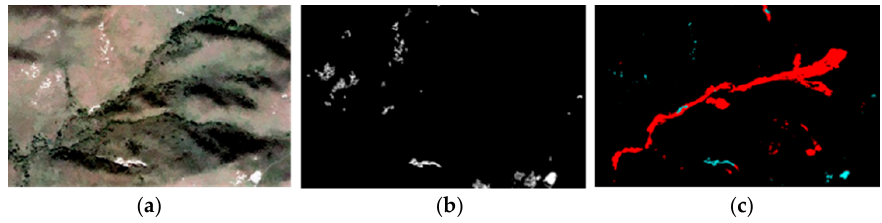
Figure 11. Reconstruction and segmentation results of the pre-event image: ( a ) reconstruction result using MMR (the structuring element is a disk of size 5 × 5); ( b ) candidate false landslide regions L pre using the threshold method, T 1 = 0.8; and ( c ) detected landslide regions according to the difference between Figures 9d and 11b, where regions marked by red color represent true landslide regions and regions marked by cyan color represent removed false landslide regions.